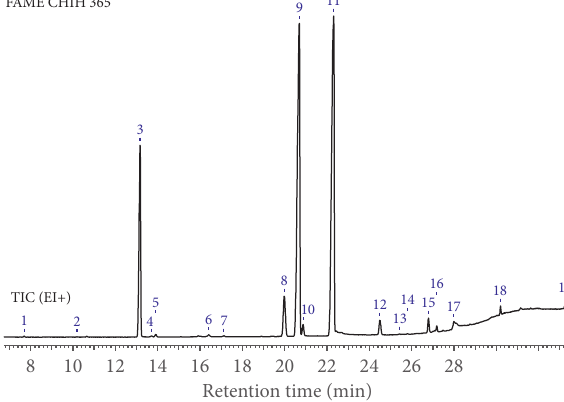
Figure 1: FAME profile of analysed maize